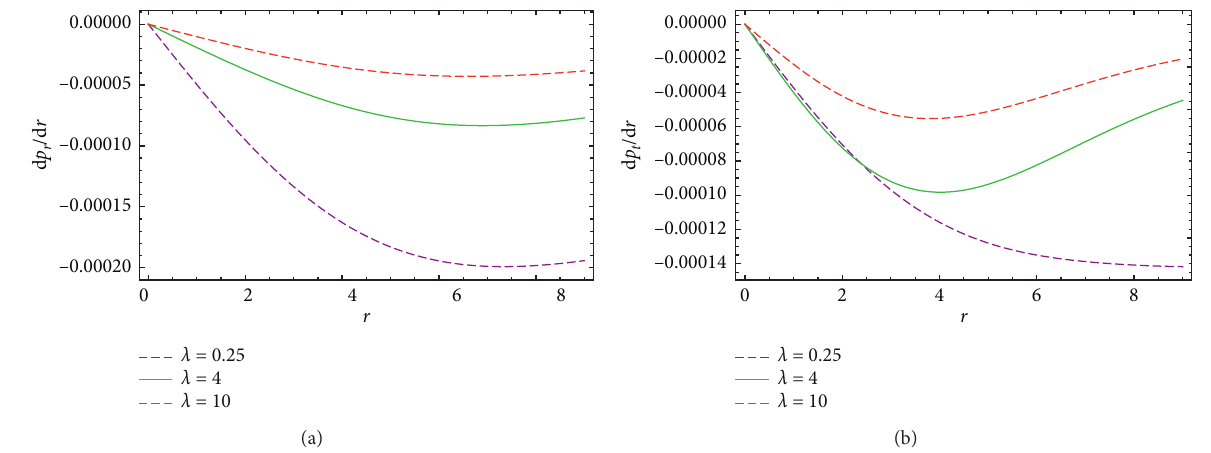
r against r and right panel shows the behavior of d ρ r /d